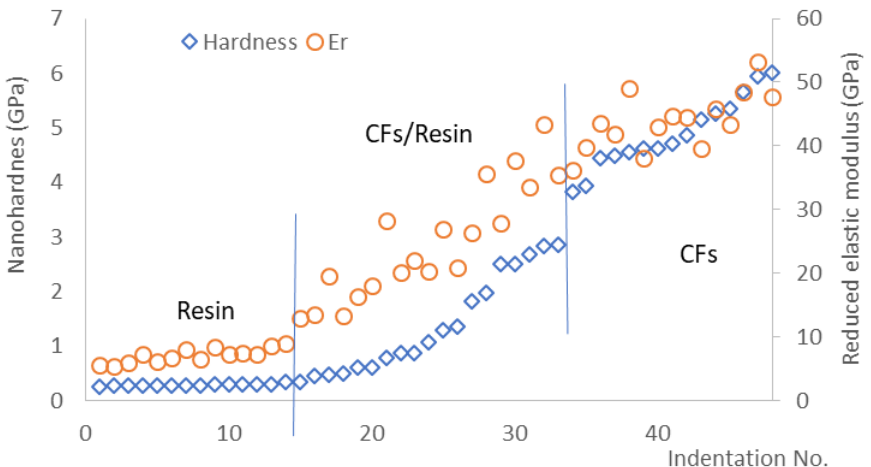
Figure 8. Nano-hardness (H) and reduced elastic modulus (Er) of sized CFs and resin in the composite measured under a load of 5 mN (T700).